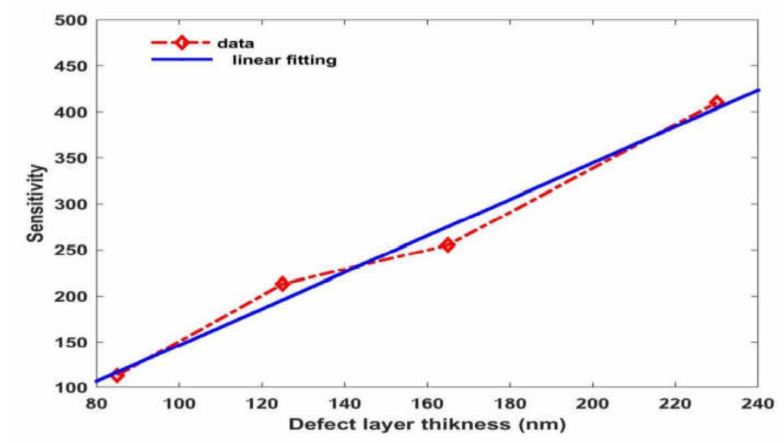
Figure 7. The sensitivity of the proposed bio-alcohol sensor as a function of the thickness of the defect layer when the cavity region is loaded with water samples containing phenol of a concentration of 30% at θ = 80 ◦ .